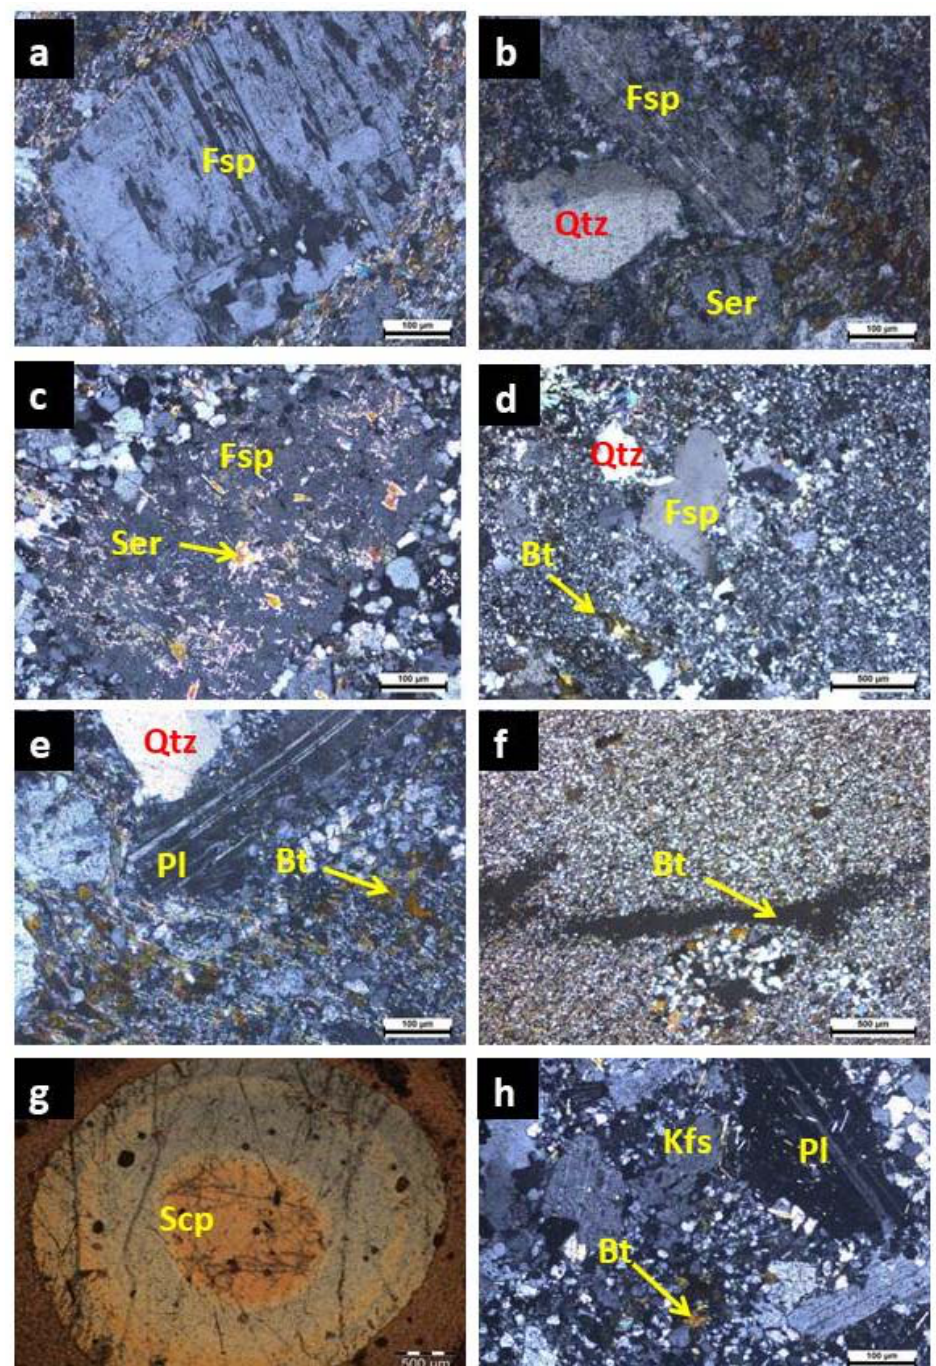
Figure 6. Photomicrographs showing ( a ) phenocryst of feldspar within the siliceous ground mass; ( b ) phenocrysts of feldspar and quartz showing corrugated margin; ( c ) sericitization of the feldspar grains observed in the felsic rock intersected; ( d ) embayment of quartz and feldspar; ( e ) foliation plane defined by the alignment of biotite and felsic ground mass in the volcanic rock; ( f ) Segregation of biotite within felsic ground mass; ( g ) large circular scapolite grain showing in the felsic tuff; ( h ) feldspar laths showing intergranular texture surrounded by biotite rich groundmass. (Bt: Biotite, Fsp: Feldspar, Kfs: K-feldspar, Pl: Plagioclase feldspar, Scp: Scapolite, Ser: Sericite and Qtz: